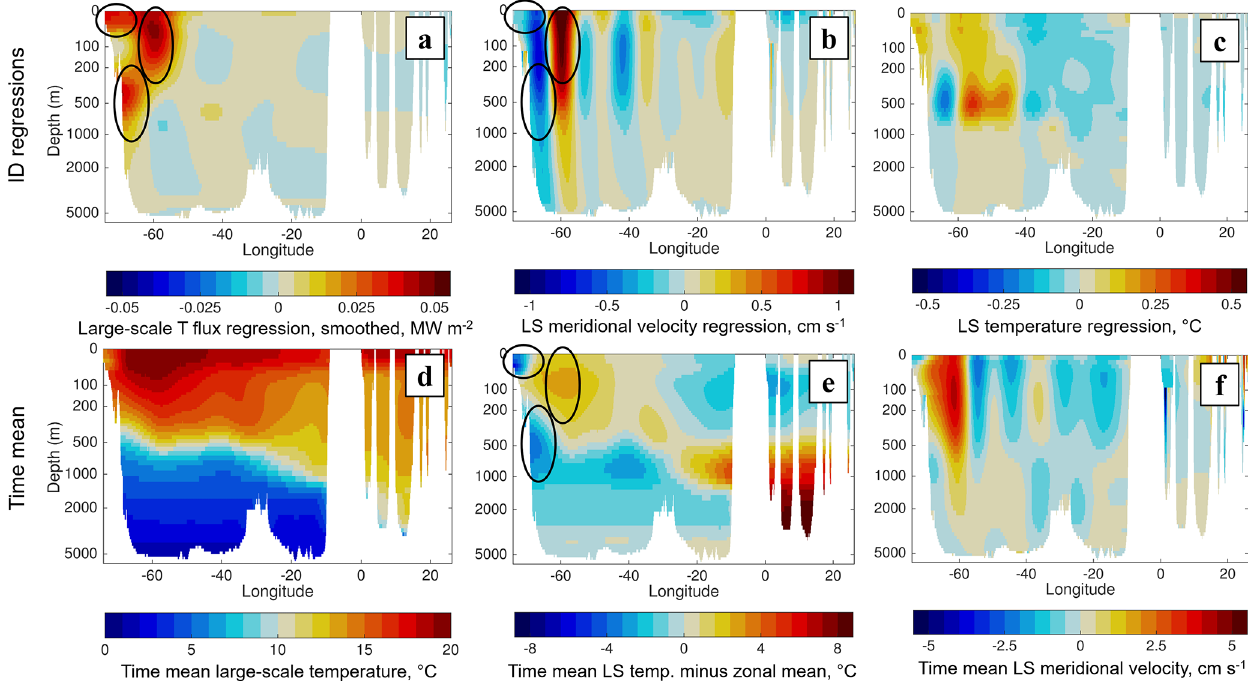
Figure 7. Components of the large-scale temperature flux variability. (a) Regression of + 1 σ of the basin-integrated large-scale (LS) temper- ature flux onto the local zonally smoothed LS temperature flux, and onto unsmoothed (b) LS meridional velocity and (c) LS temperature. (d–f) Time mean, unsmoothed structure of LS temperature (d) with zonal mean and (e) without zonal mean, and (f) time-mean LS velocity structure. Ellipses indicate areas of contribution to the LTF from time-variable LS meridional velocity and time-mean LS temperature v (cid:48)